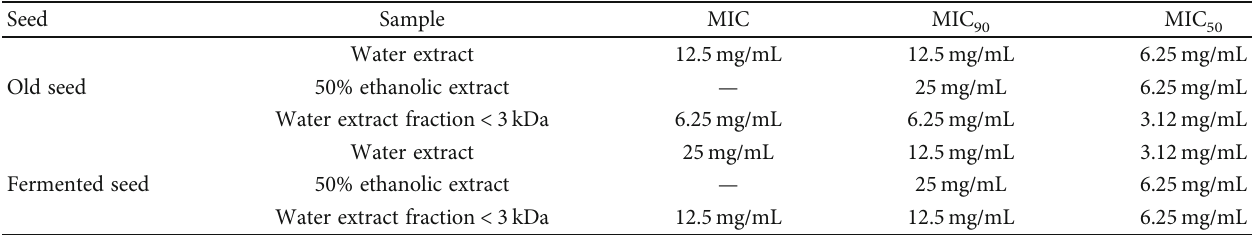
, and MIC that were determined using the agar dilution method. 90 50